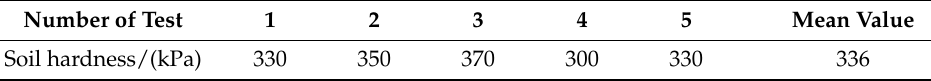
Table 2. Soil hardness. Table 3. Soil moisture content (%).